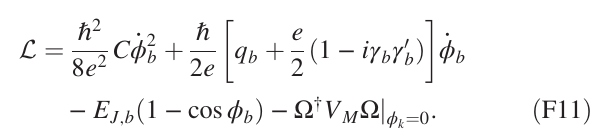
The low-energy subspace of the Hamiltonian in Eq. (F9)